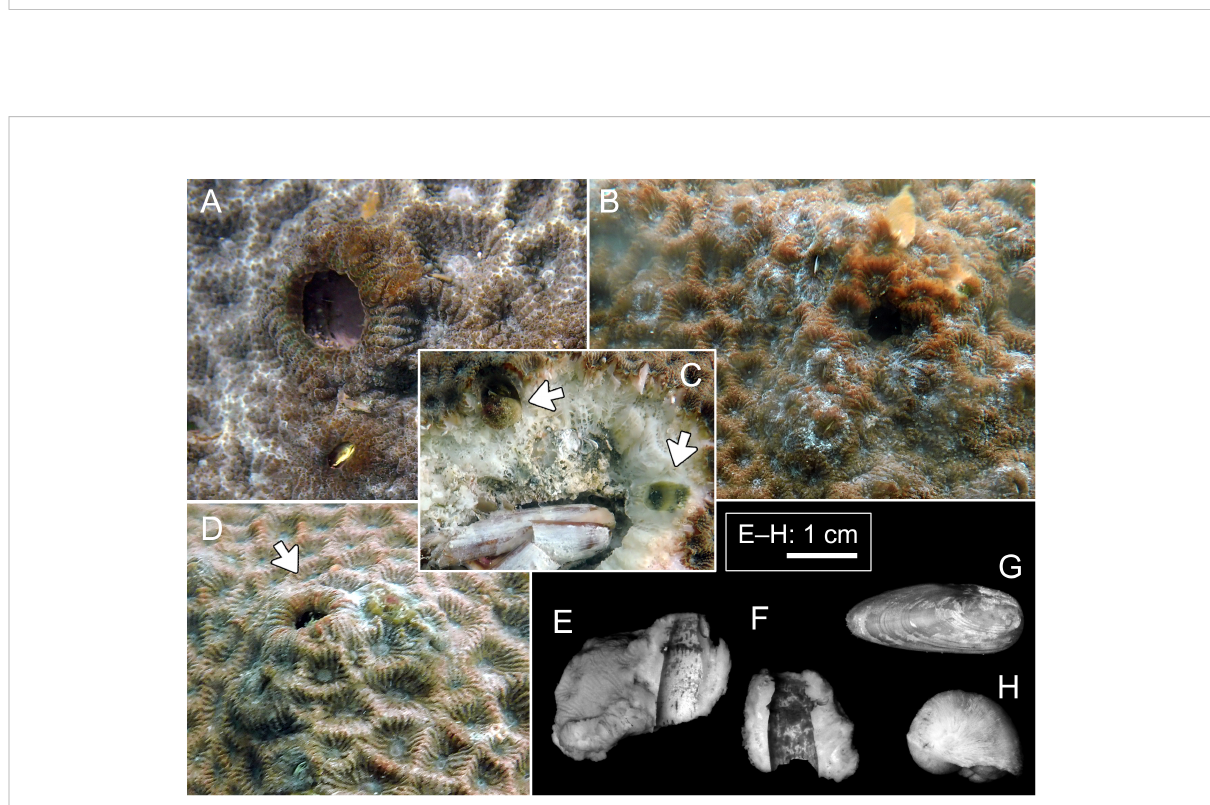
FIGURE 3 Host and domicile of Lithoscaptus scottae sp. nov. (A – D) Coelastrea aspera , Pak Lap Tsai. Arrows in panel (C) showing two retrieved crabs; arrow in panel (D) showing opening of domicile. Cross-section of domicile: (E, F) Pak Lap Tsai. Boring mollusks found within the same colony of C. aspera : (G) Lithophaga sp.; (H) Leptoconchus